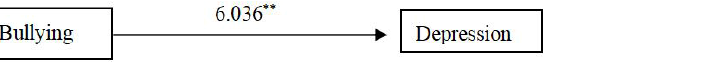
Figure 1. The pathway of predicting depression by school bullying. Note: ** p < 0.01, the value on the arrow indicates the B value of the regression